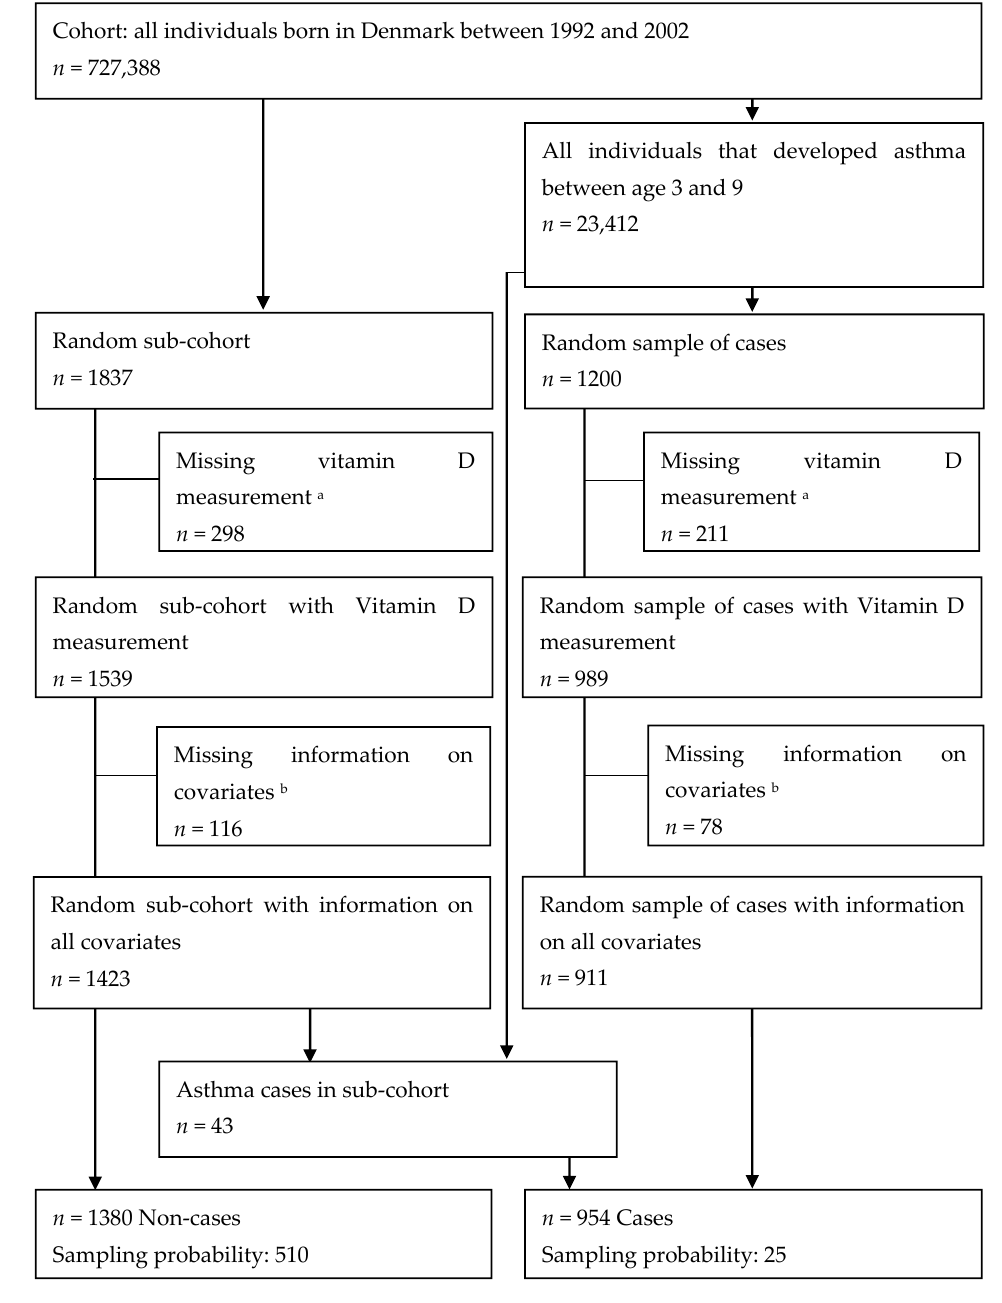
Figure 1. Flowchart of the study population. a Dried blood spot samples (DBSS) not found, analyses failed or insufficient material for analysis. b Information on all covariates not available in the registers.